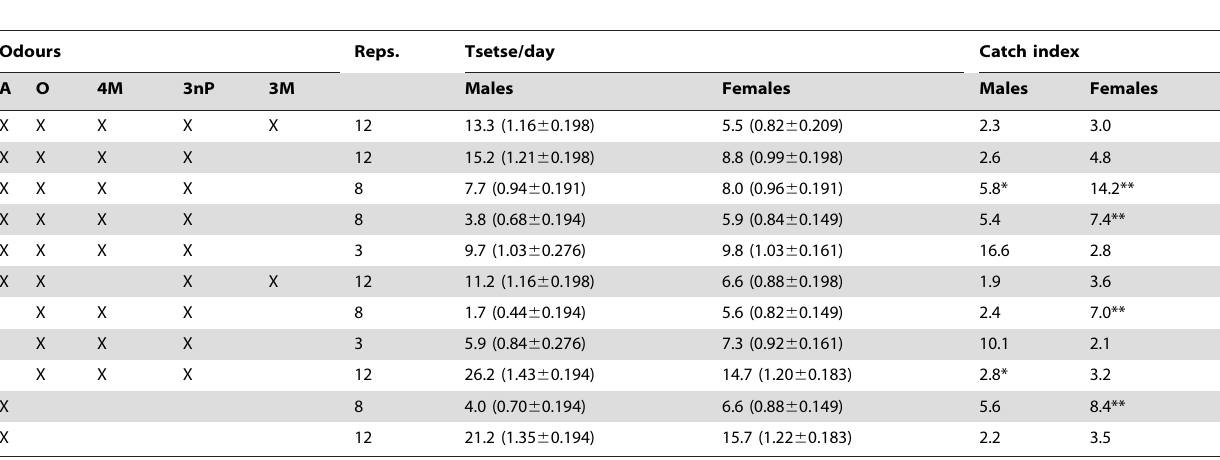
Table 4. Detransformed mean daily catch (transformed means 6 SED in brackets) of G. tachinoides from traps baited with synthetic host odours.